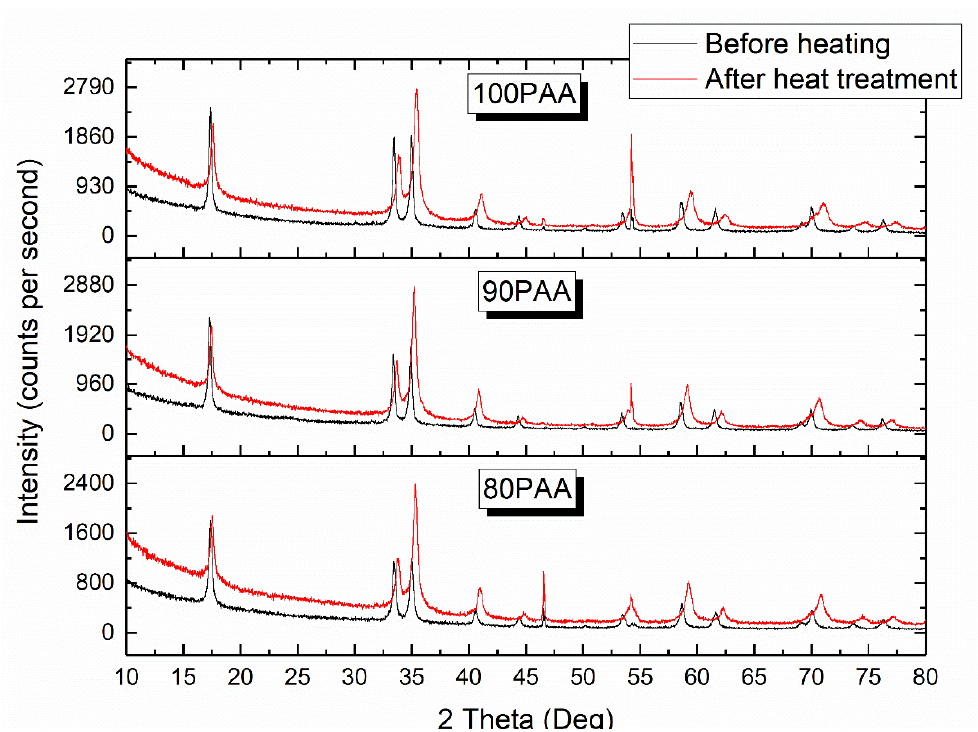
Figure 5. Comparison of XRD pattens for 100PAA, 90PAA and 80PAA before and after heat treatment.